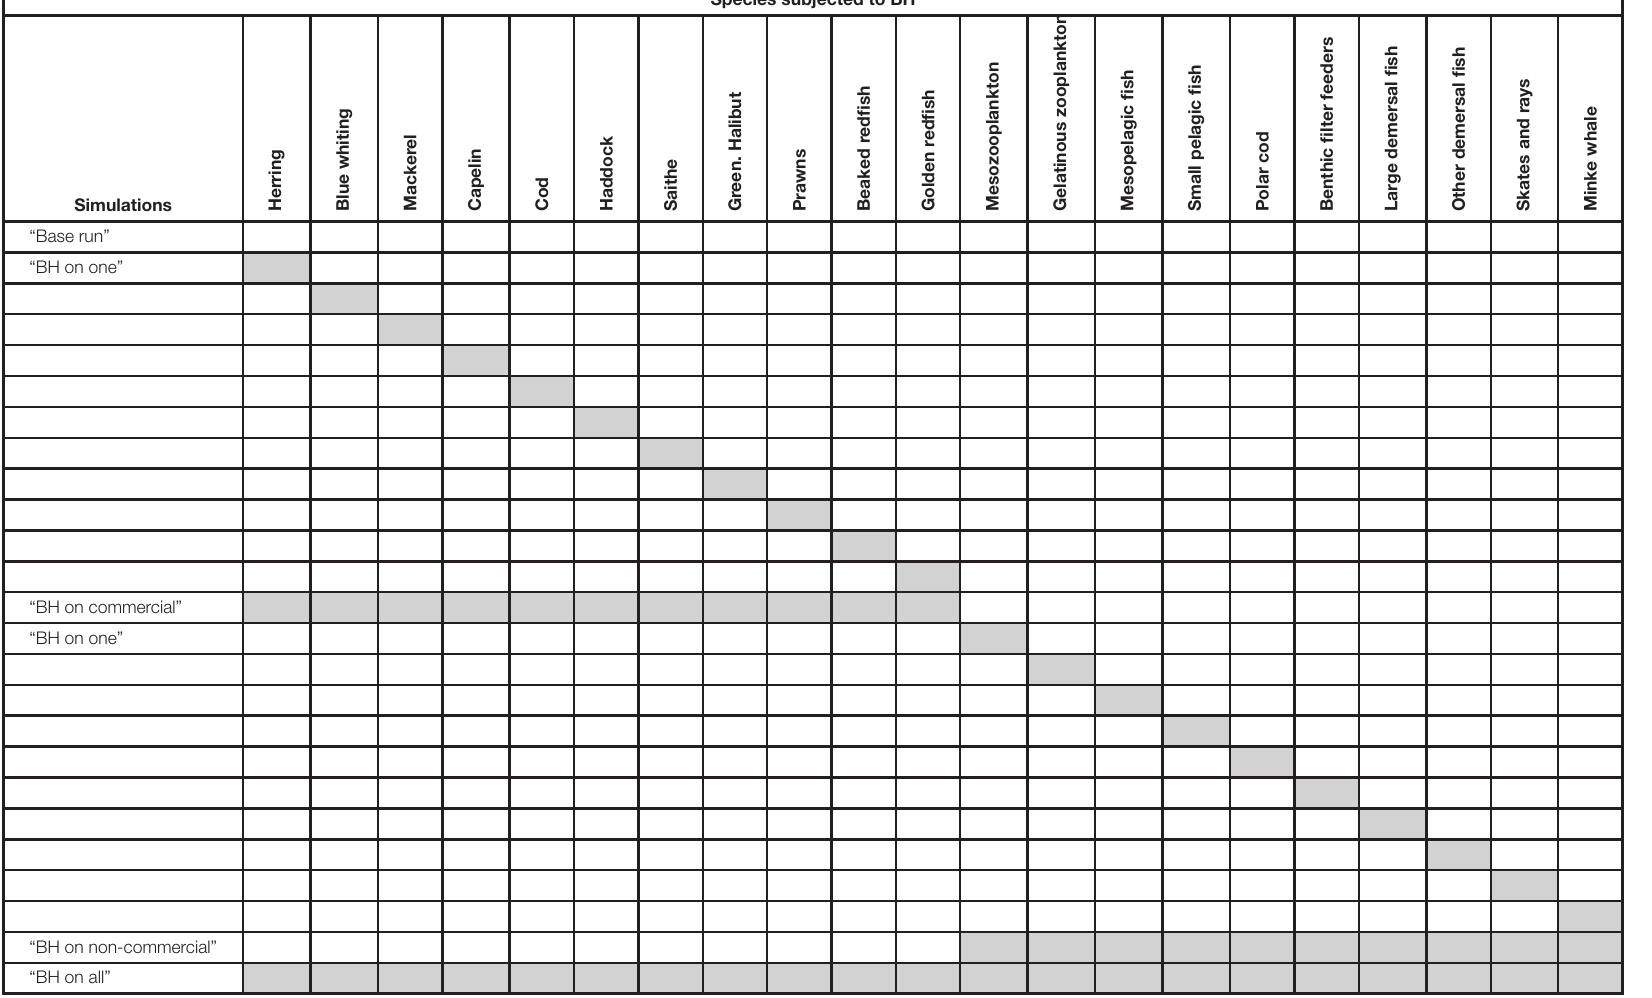
TABLE 3 | List of all simulations selected for